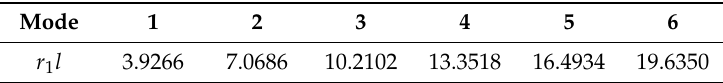
Table 2. First six solutions of r 1 l for fixed-pinned double-beam